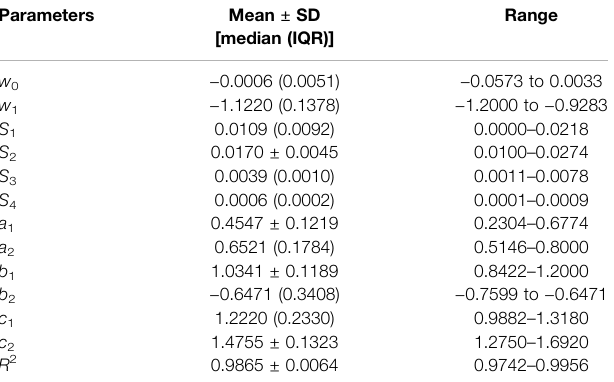
TABLE 3 | The fi tted parameters of S ( r , t ). Parameters